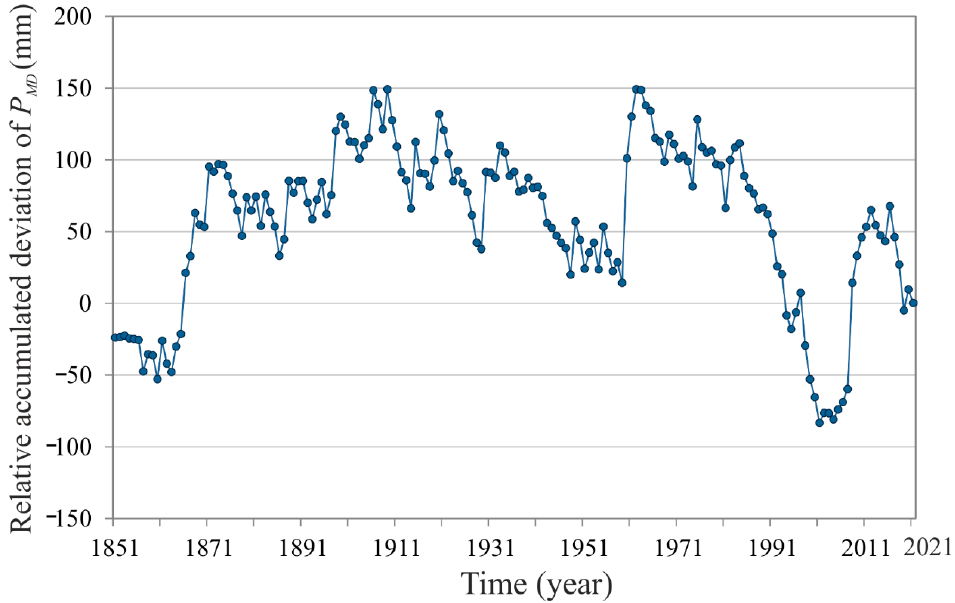
Figure 3. Relative accumulated deviation A n of P MD with respect to risk threshold R L .